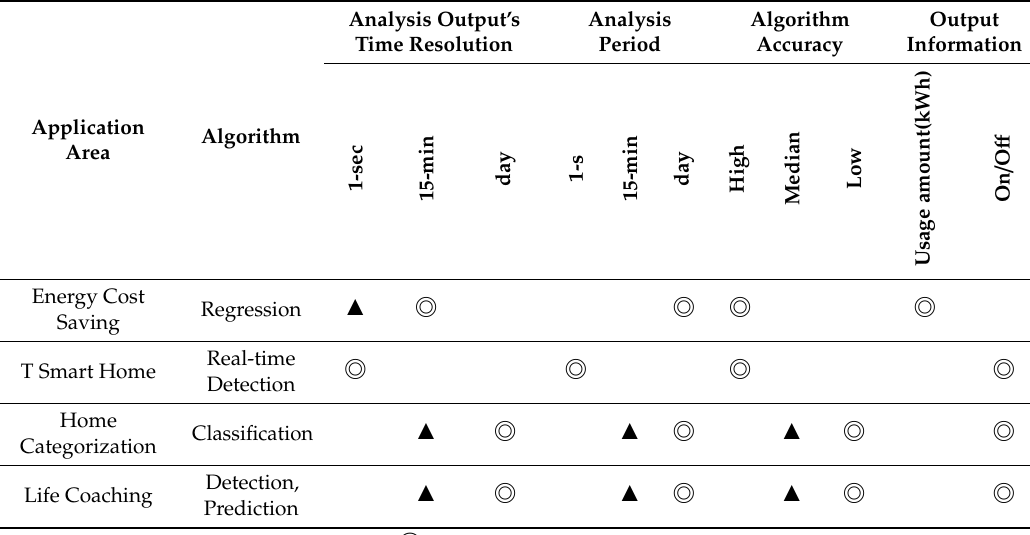
Table 2. Requirements for providing useful services.